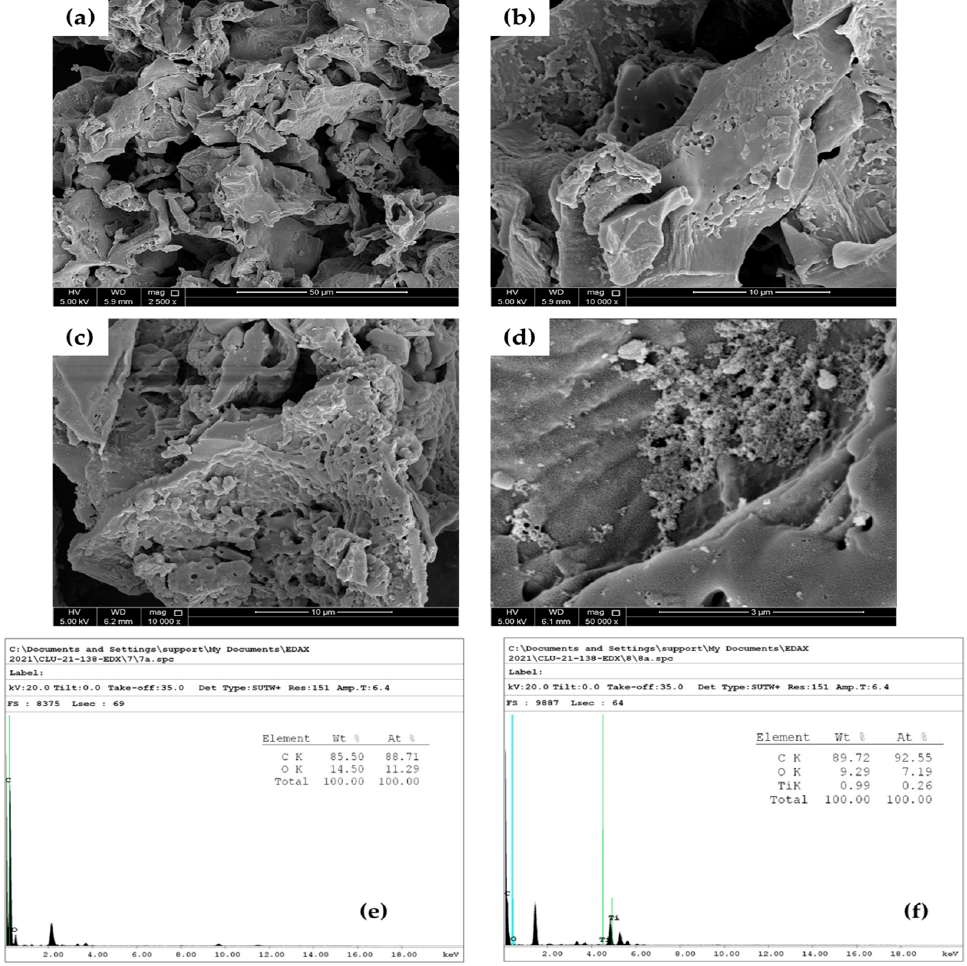
Figure 5. SEM micrographs of ( a , b ) the SCBC (at 2500 × and 10,000 × magnifications), ( c , d ) the TiO 2 @SCBC (at 10,000 × and 50,000 × magnifications), ( e , f ) EDS analyses of the SCBC and the TiO 2 @SCBC, respectively.